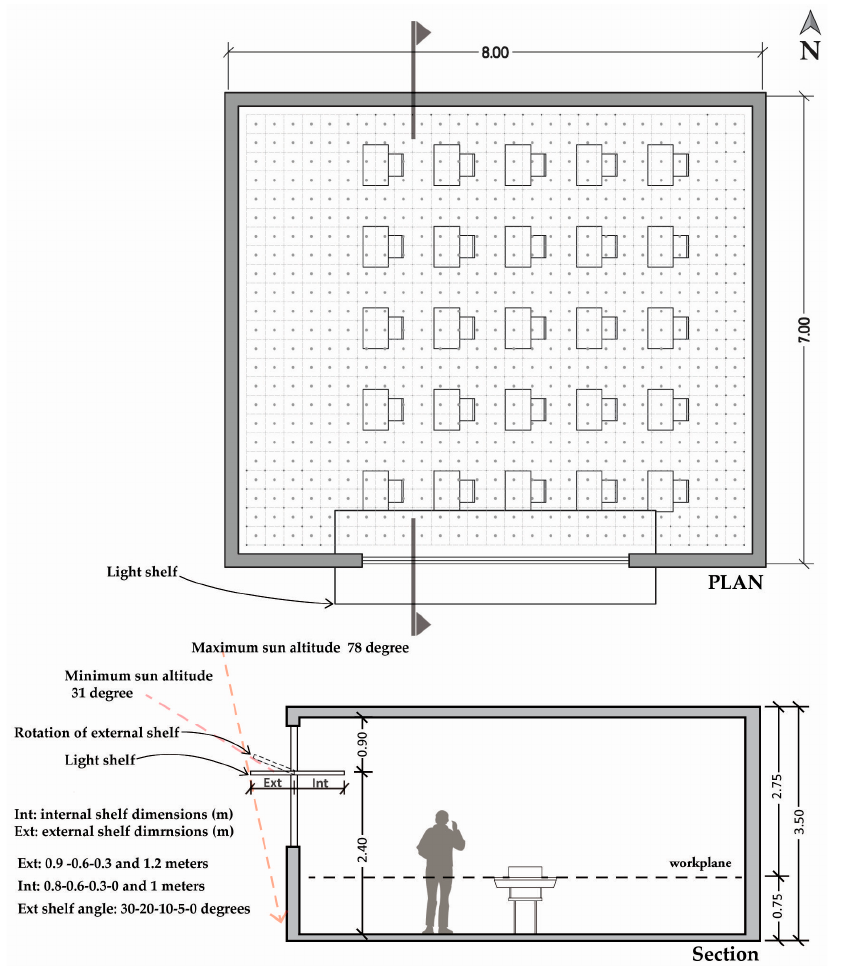
Figure 1. Classroom dimensions, work plane and shelf location; in addition to the southern orientation, northern, eastern and western orientations have also been studied.